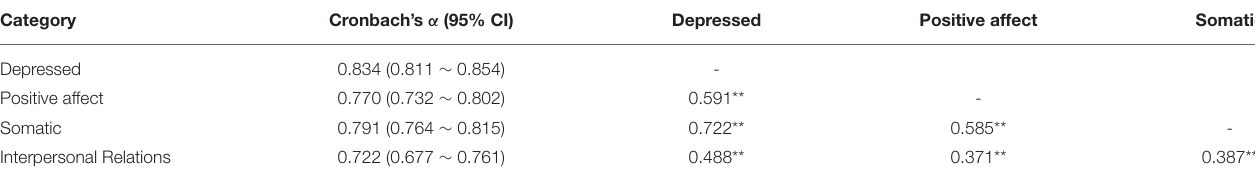
TABLE 4 | Internal Consistency and correlation of the Four-Factor Model of the